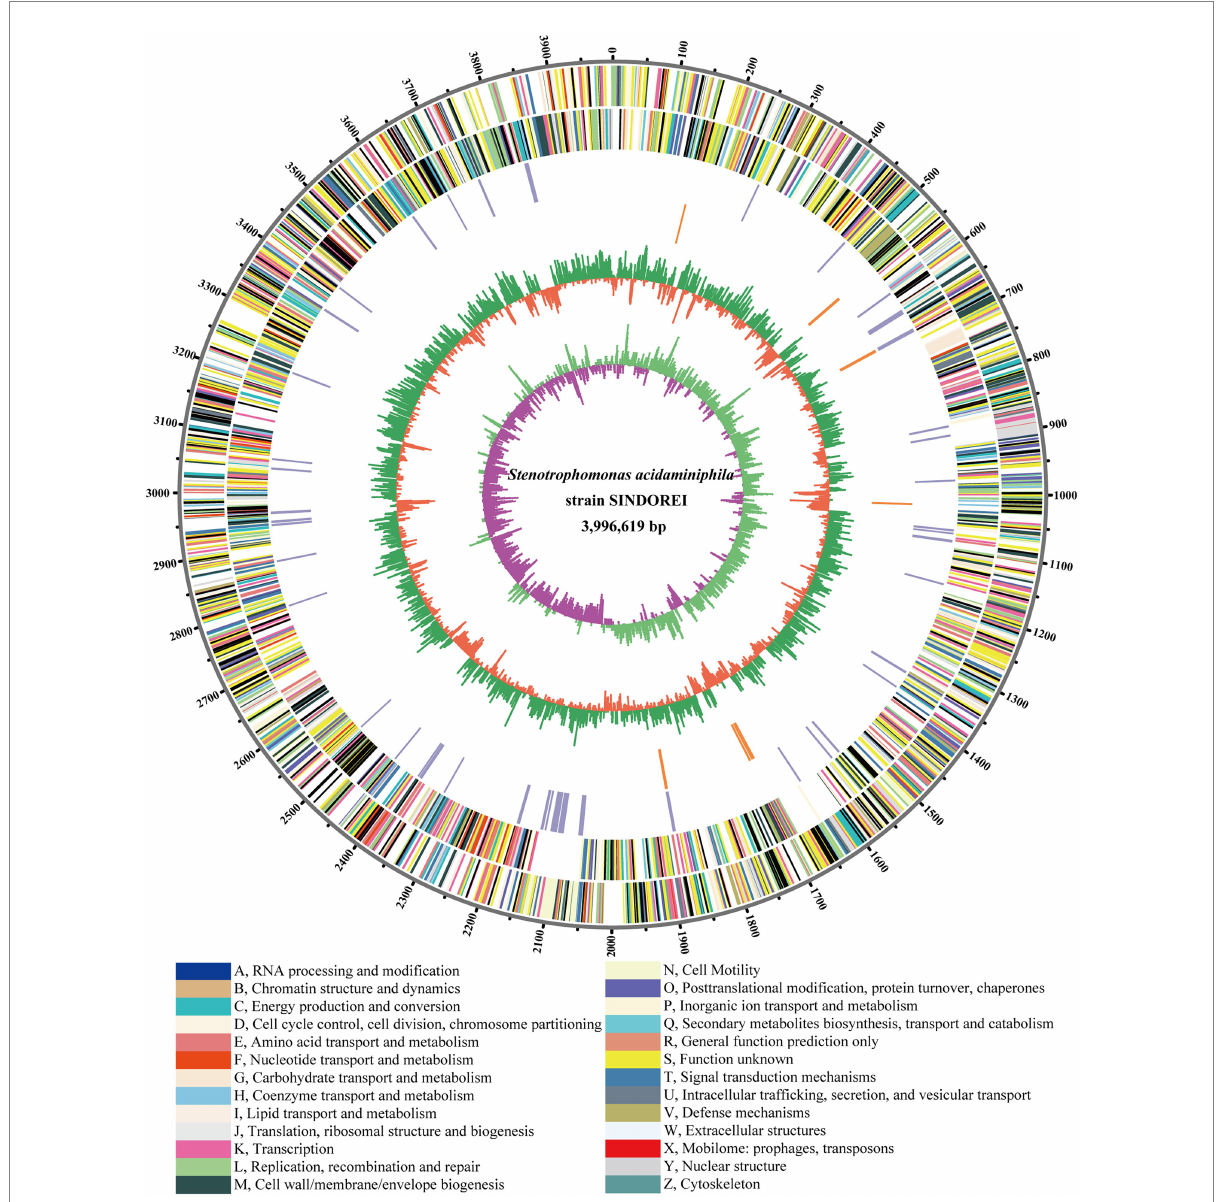
FIGURE 1 Circular plot of Stenotrophomonas acidaminiphila SINDORE genome generated by circos. Predicted Coding Sequences (CDSs) are presented by various colors according to cellular functions. The Circles from outside to inside: 1, the scale line. 2, CDSs on forward strands. 3, CDSs on reverse strands. 4, virulent genes. 5, resistant genes. 6, GC plot, above average in green and below average in violet, respectively. 7, GC skew showing regions above and below average in yellow and light blue,